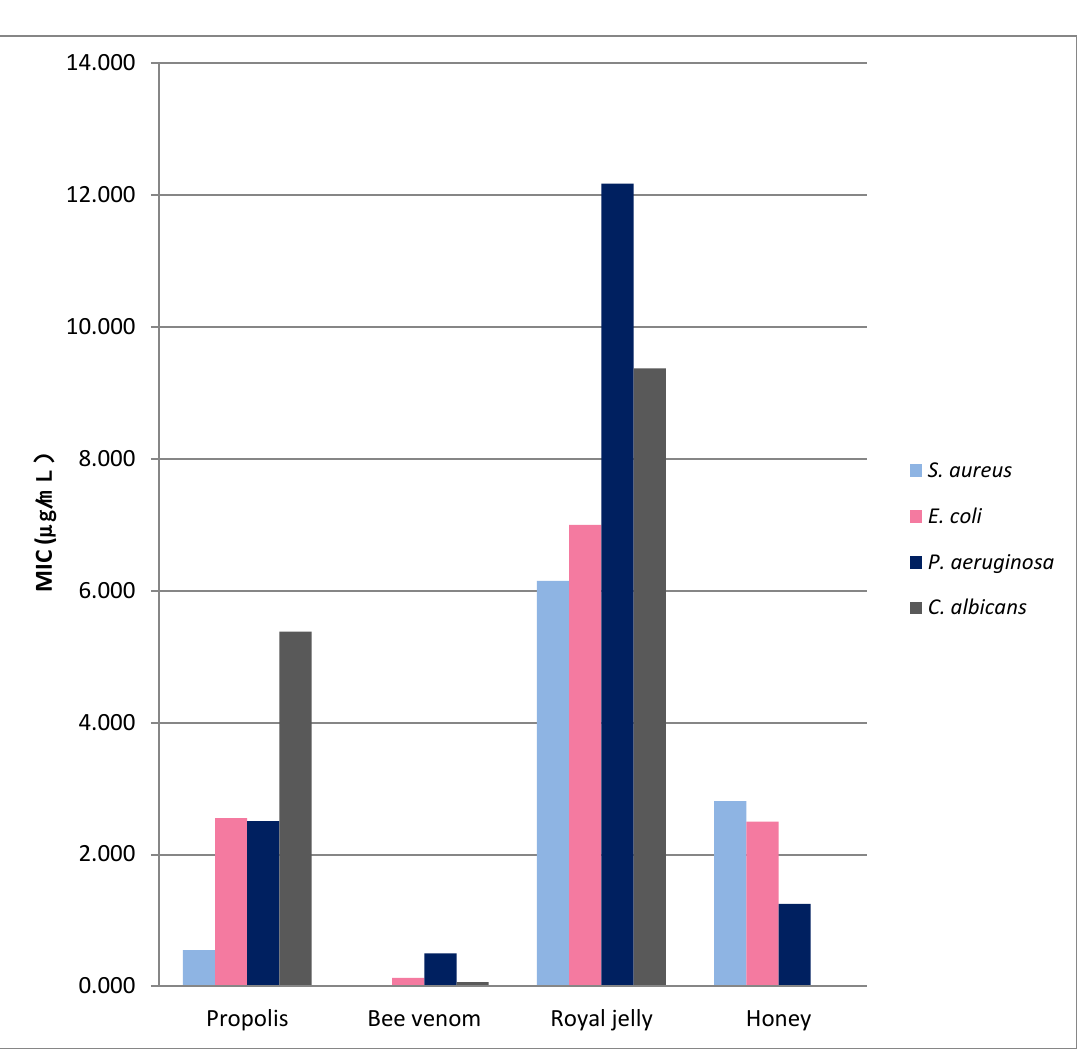
Figure 1. Antimicrobial activity of bee products. The graph shows the arithmetic mean MIC values for the most commonly tested microorganisms. Only experiments in which the MIC value was determined were included in the analysis. There are significant differences in the effects of individual bee products on different bacteria (propolis 10-fold, BV 35-fold and RJ 2-fold differences). BV showed the best antibacterial activity against all analyzed microorganisms (mean MIC values in the range from 13.98 µg/mL ( S. aureus ) to 500 µg/mL ( P. aeruginosa )). The composition of bioactive compounds of bee products is variable due to various geographical origins. Selected bioactive compounds responsible for the antibacterial ac- tivity are presented in Table 4. Table 4. Chemical structure and amino acid sequence of bioactive compounds from bee products as antimicrobial agents. Type of Bee Product